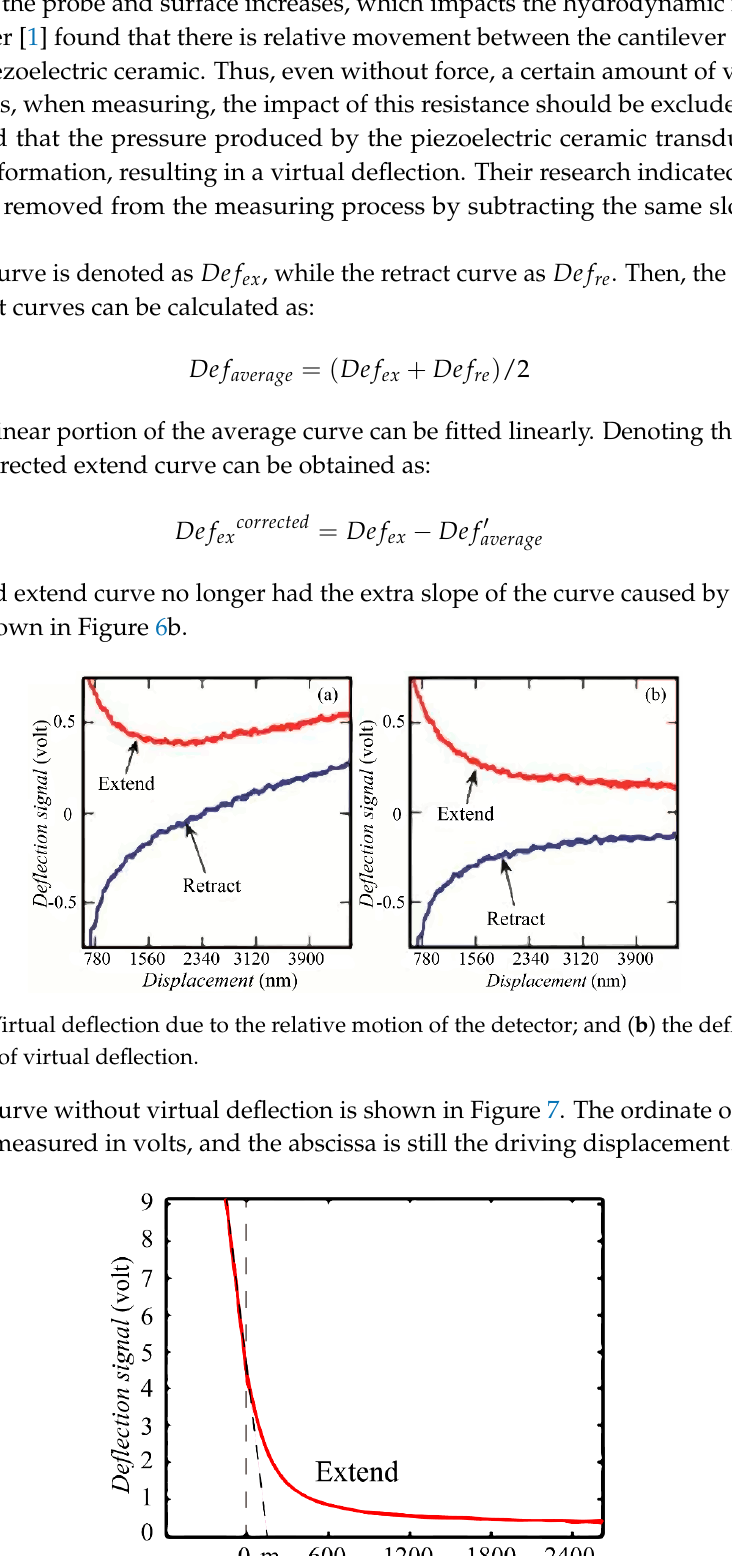
Figure 7. Process curve after removing virtual deflection.